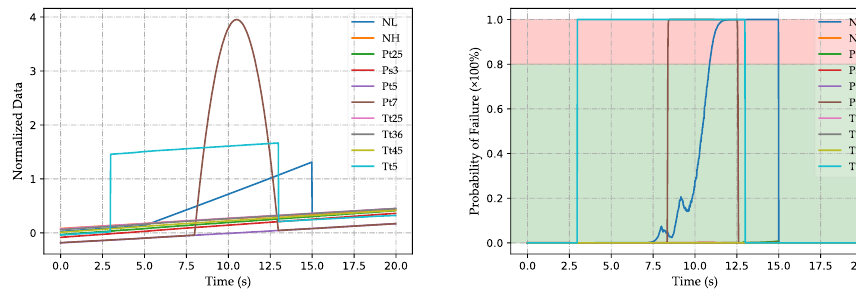
Figure 13. Detection of simultaneous failure of multiple sensors in transition